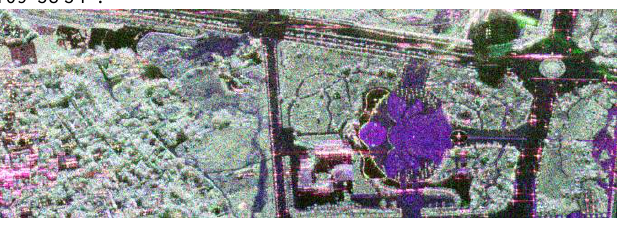
Figure 3. Cross-polarization signature of trihedral corner reflector. (Left: Set to be 0.5, Right: Set to be 1.5, (a): The original method, (b): The proposed method) Figure3 (a) and (b) are the cross-polarization signatures after original and the modified method calibration, respectively set k to be 0.5 and 1.5. After cross-channel imbalance and better cross-polarization signature of than the original method.